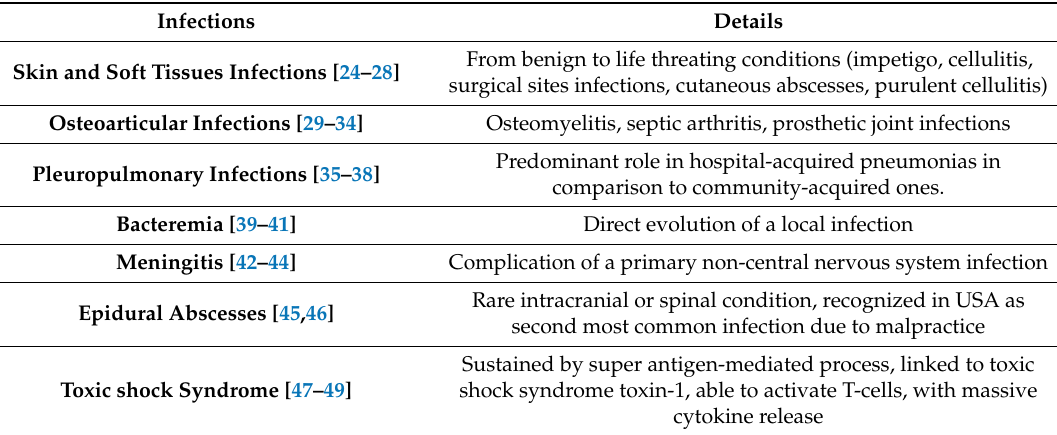
Table 2. S. aureus related